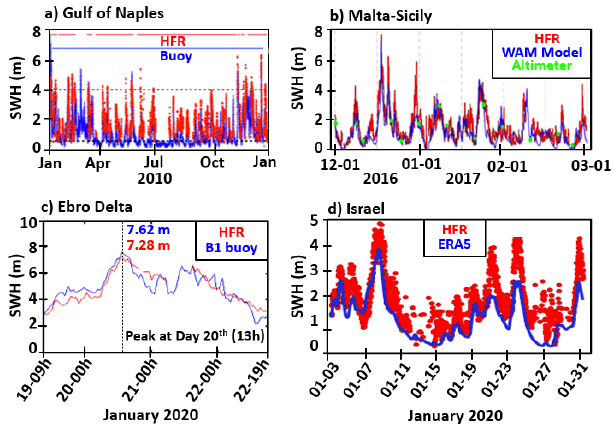
Figure 5. (a) Time series of SWH provided by HFR-GoN (SORR site) and a buoy deployed in the GoN (Fig. 1). Timelines of data availability provided at the top. Dotted lines represent the theoreti- cal upper and lower detectability thresholds of this HFR. (b) Time series of SWH (averaged in time and space) provided by HFR- Calypso (arc 3 of Barkat site), the WAM model, and an altime- ter during a storm in the Malta–Sicily Channel. (c) Time series of SWH provided by HFR-DeltaEbro (arcs 4–9 of ALFA site) and the B1 buoy during storm Gloria in the NW Mediterranean Sea. (d) Time series of SWH ( ∼ 20km offshore of Israel) as measured by HFR-Israel (Fig. 1). Preliminary uncalibrated data using Gurgel and Schlick (2006) were compared with ERA5 wave reanalysis (from the